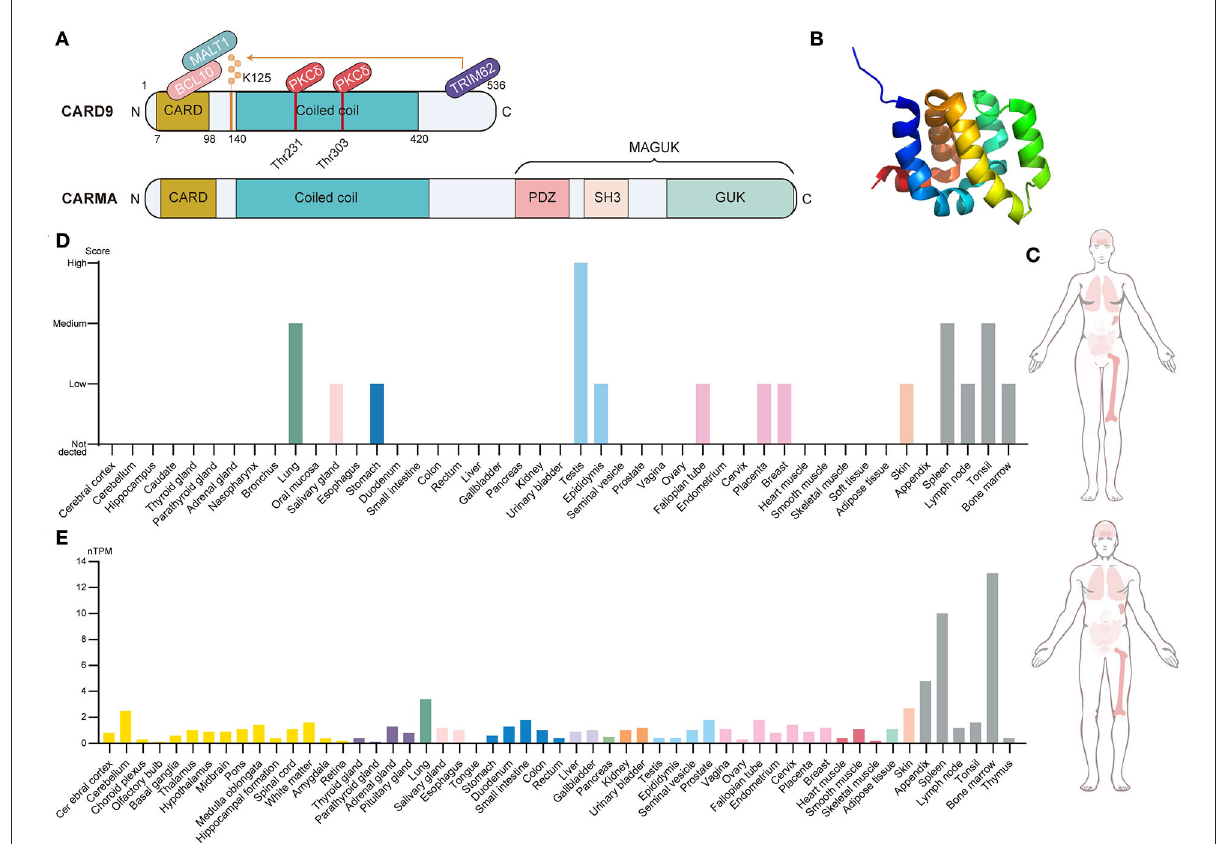
FIGURE1 Brief introduction to CARD9. (A) Structural features, protein-interacting domains, and post-translational modification sites of CARD9 and CARMA. CARD9 and CARMA family have a similar structure in which the N-terminal CARD domain, the coiled-coil domain, and the C-terminal tail are shared. Apart from these, CARMA still contains the C-terminal MAGUK region, which includes the PDZ domain, SH3 domain, and GUK domain. PKC δ -mediated phosphorylation (Thr 231 and Thr 303) and TRIM62-mediated ubiquitination (Lys 125) are required for the activation of CARD9. BCL10 interacts with activated CARD9 on the homologous CARD domain, and then they bind to MALT1 to induce the assembly of the trimolecular complex. (B) The NMR solution structure of the CARD9 CARD. Image from the RCSB PDB (RCSB PDB accession code PDB 6E26). (C) Integrated RNA and protein expression of CARD9 in the various normal tissues of a different gender. The color shade of the tissues represents the extent of expression (Data from The Human Protein Atlas). (D) CARD9 protein expression overview categorized by the system. Color coding is based on tissue groups that contain tissues with functional features in common (Data from The Human Protein Atlas). (E) CARD9 RNA expression overview categorized by the system. Color coding is based on tissue groups that contain tissues with functional features in common. nTPM represents the normalized expression of RNA (Data from The Human Protein Atlas). MAGUK, membrane-associated guanylate kinase; SH3, Src Homology 3; GUK, Guanylate Kinase; MALT, mucosa-associated lymphoid tissue lymphoma; BCL10, B cell lymphoma 10; PKC δ , protein kinase C δ